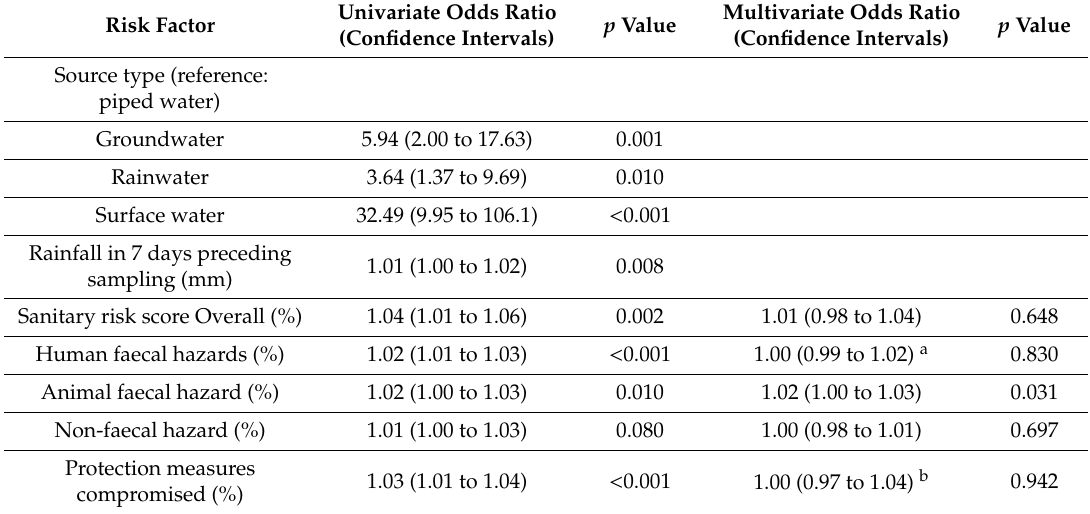
Table 3. Odds ratios for risk factors for high contamination ( > 150 CFU / 100 mL) of source water with intestinal enterococci based on logistic regression of 130 samples from 93 water points.